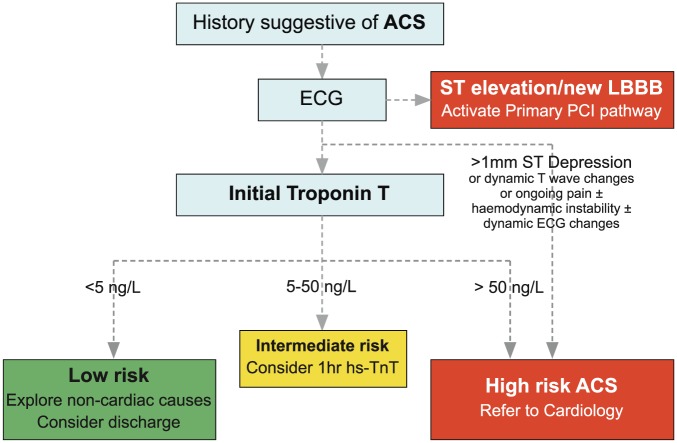
The high-sensitivity troponin T (hs-cTnT) rapid diagnostic algorithm introduced at St Thomas’ Hospital.ACS: Acute Coronary Syndrome; LBBB: Left Bundle Branch Block; ECG: electrocardiogram; PCI: Percutaneous Coronary Intervention.